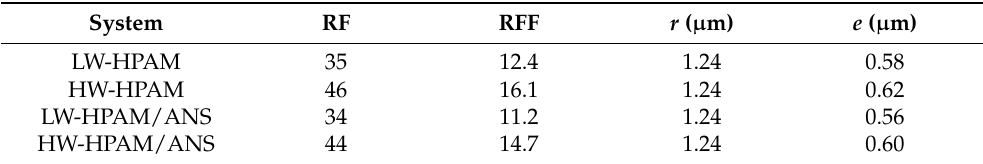
Table 3. Flow test summary and adsorption parameters of 3.0 g · L − 1 HPAM with and